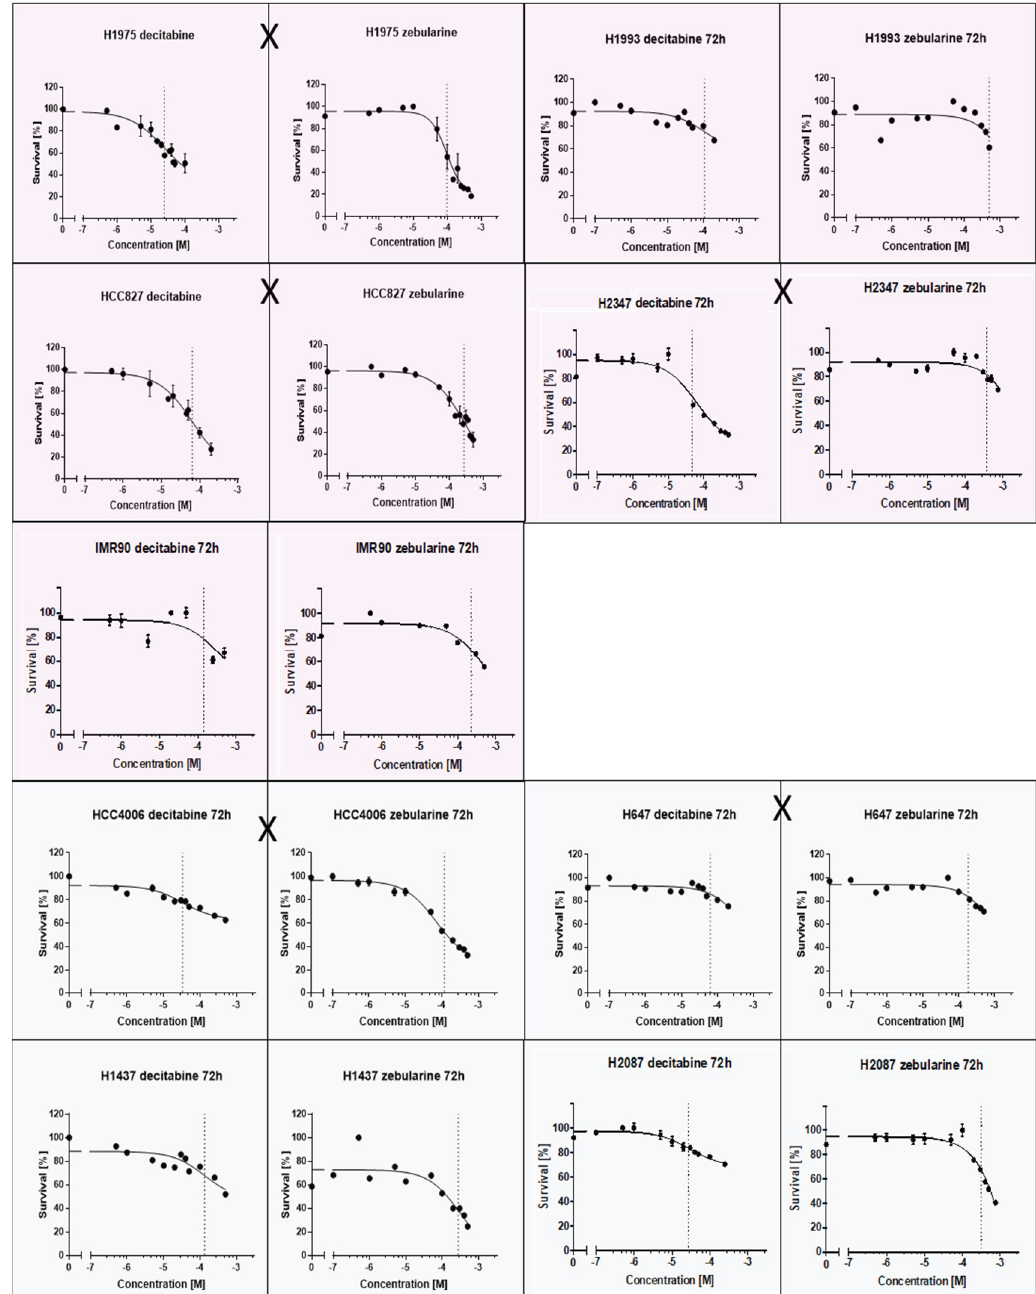
Figure 3. Dose-response curves of NSCLC-cell lines treated with the DNMTIs decitabine and zebularine; shading discriminates male (blue) and female (pink) cell lines. EGFR/KRAS mutation is indicated by an X between the two curves of a cell line. Table 4. Summary of the EC 50 values and viability reductions achieved for the lung cancer (LC) (IMR90 is benign) cell lines treated with the DNA methyl-transferase inhibitors (DNMTIs) decitabine and zebularine. For H1975, HCC827, HCC4006, and H1437, additional EC 50 values for tyrosine kinase inhibitor (TKI) treatments with gefitinib and erlotinib are shown. Student’s t-test gave no statistically significant p -value comparing viability reduction and EC 50 values for female vs. male cancerous cell lines (decitabine: p = 0.22, zebularine: p = 0.41). A statistically significant difference between the decitabine EC 50 values of mut versus wt cell lines was found ( p = 0.01). No statistical significance was reached for zebularine ( p = 0.12) (Figure 4). A Mann–Whitney U test for the EC 50 values of cancerous